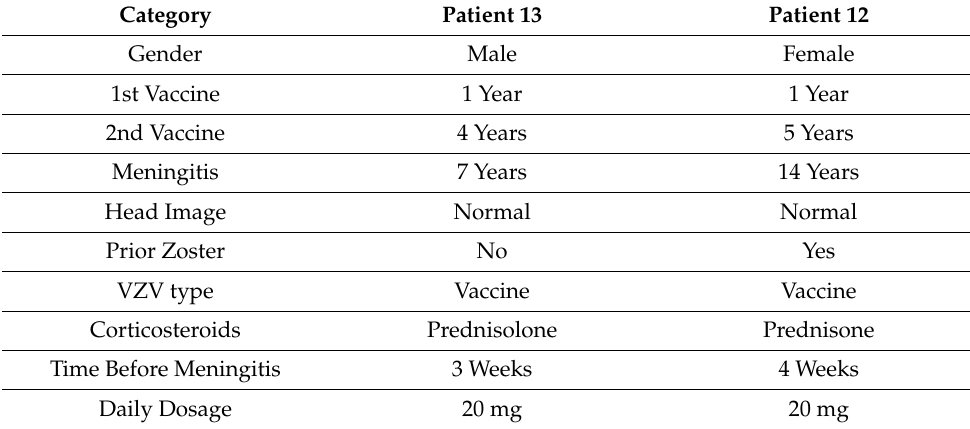
Table 1. History of corticosteroid burst before varicella